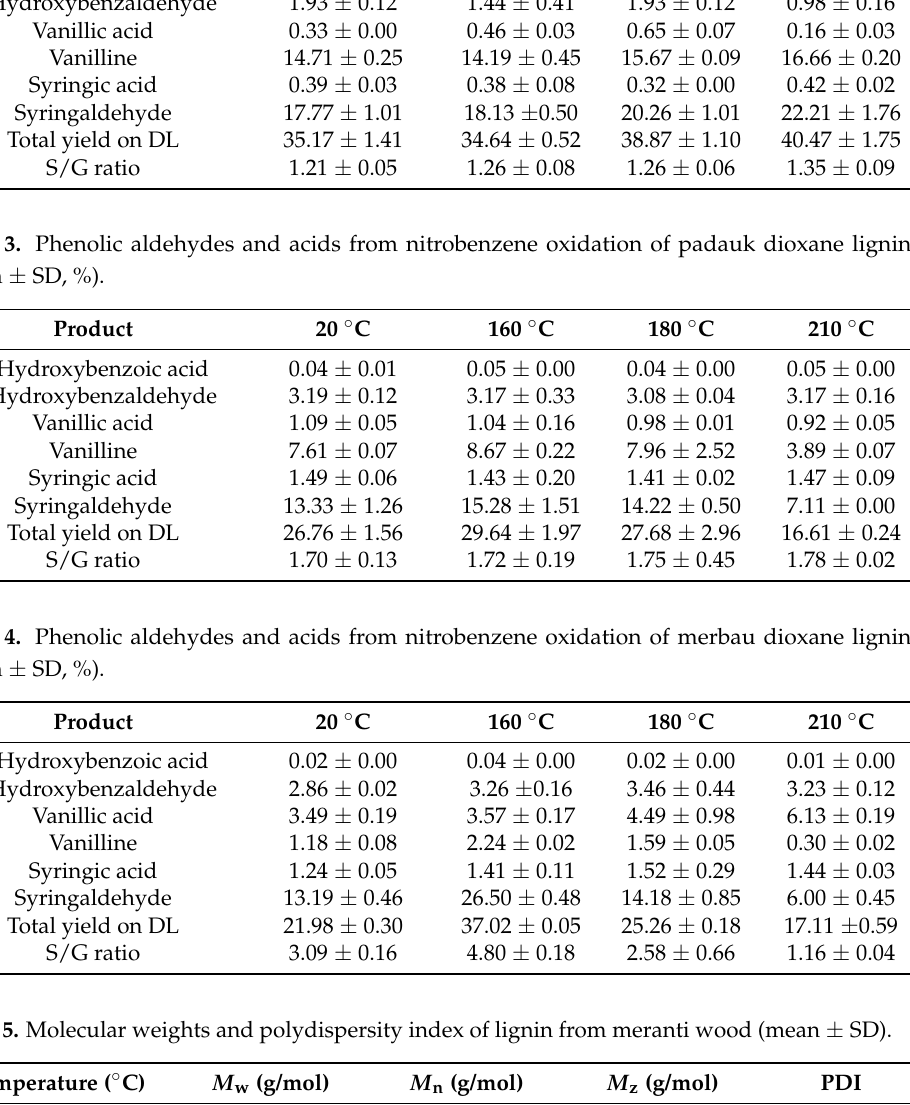
Table 5. Molecular weights and polydispersity index of lignin from meranti wood (mean ± SD).